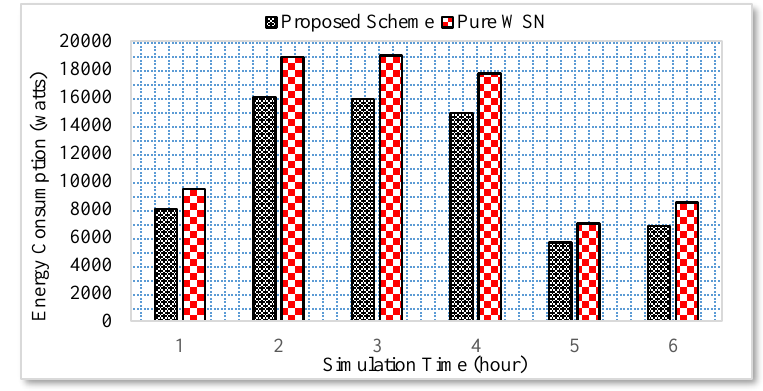
Figure 7. Energy consumption of entire home.